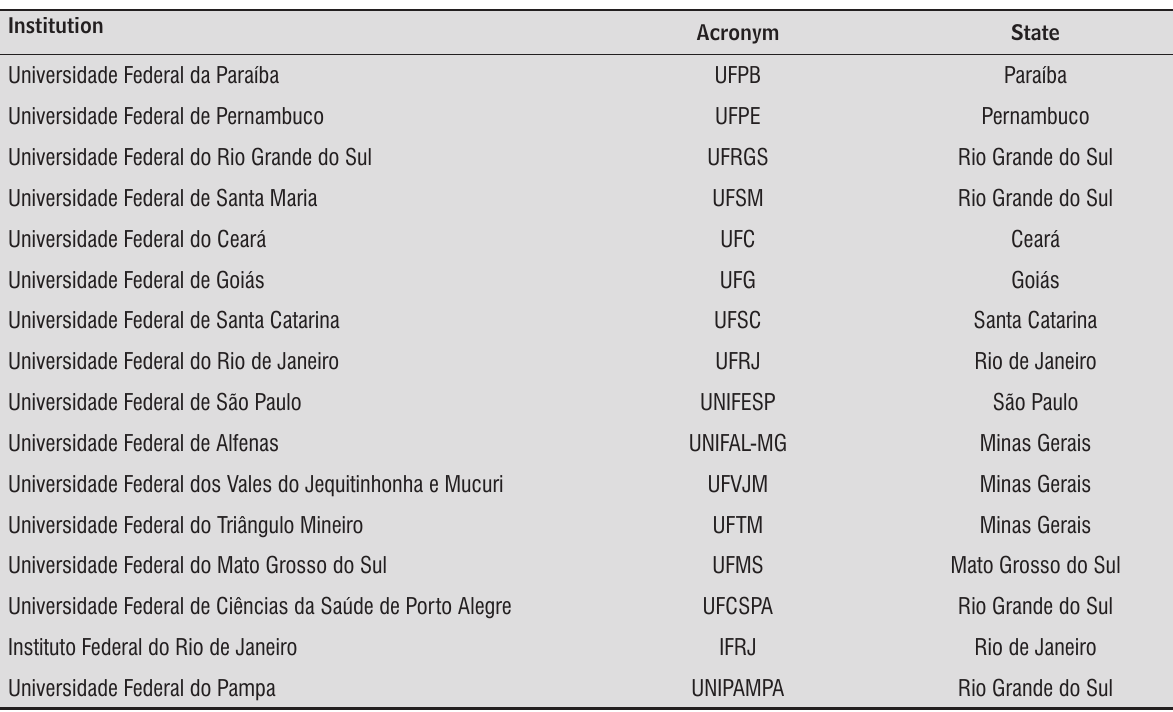
Table 1 - Distribution of Brazilian federal higher education institutions with undergraduate physical therapy programs by